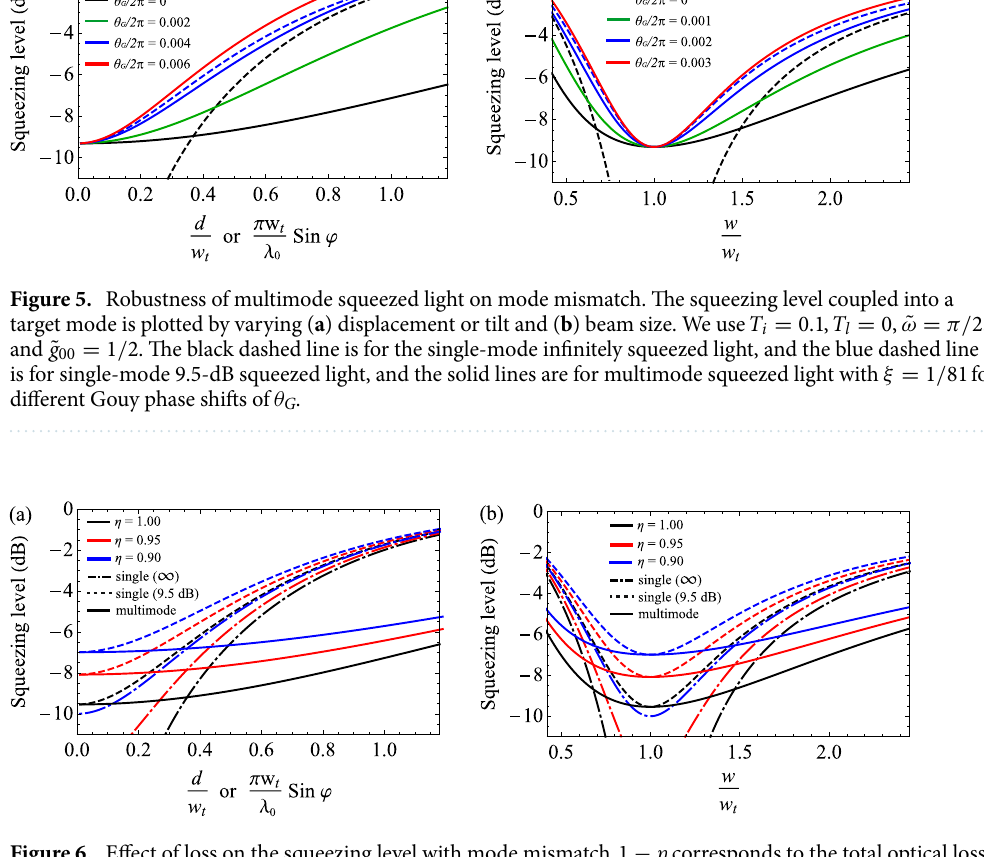
Figure 6. Effect of loss on the squeezing level with mode mismatch. 1 (e.g. by including the detection inefficiency). For different amounts of η (blue), the performances of three different squeezed lights are compared (dot dashed: single-mode infinitely squeezed light, dashed: single-mode 9.5-dB squeezed light, and solid: multimode squeezed light with ξ We use the following parameters for the